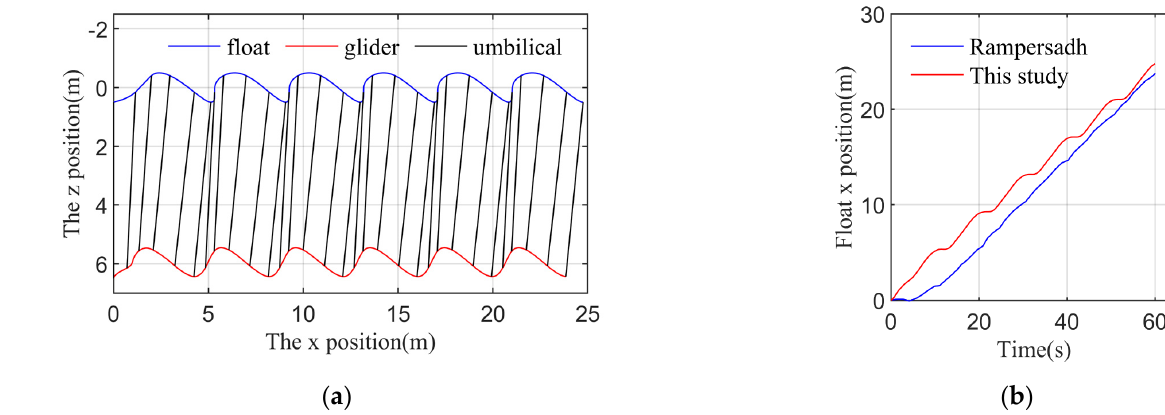
Figure 21. Simulation results with the specific sea state. ( a ) The x-z view of the wave glider; ( b ) comparison result.